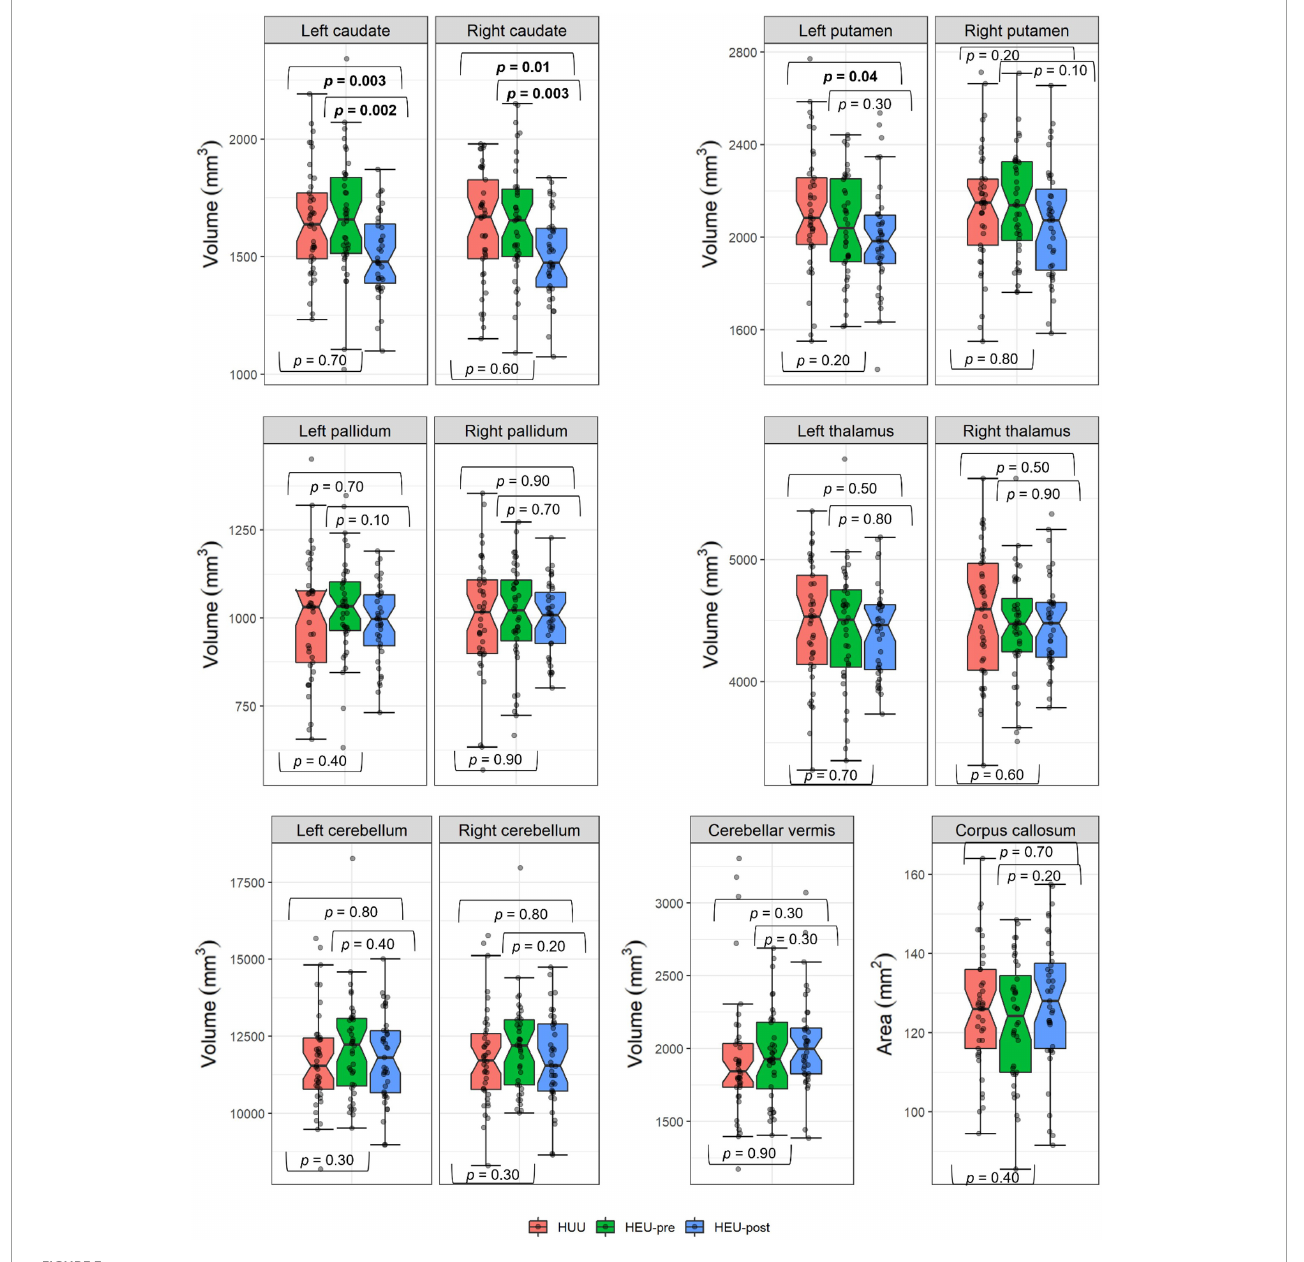
FIGURE3 Comparison of regional volumes by group. The HEU group comprised infants who were HIV-exposed but uninfected born to mothers who had either initiated ART pre-conception (HEU-pre) or during gestation (post-conception; HEU-post); HUU are infants who were not HIV-exposed or infected. Hourglasses show median and interquartile ranges; whiskers are upper and lower extremes. Values above and below the whiskers are outliers, defined as data points more than 1.5 times the interquartile range above (or below) the upper (or lower) quartile. p values from independent one-tail student t